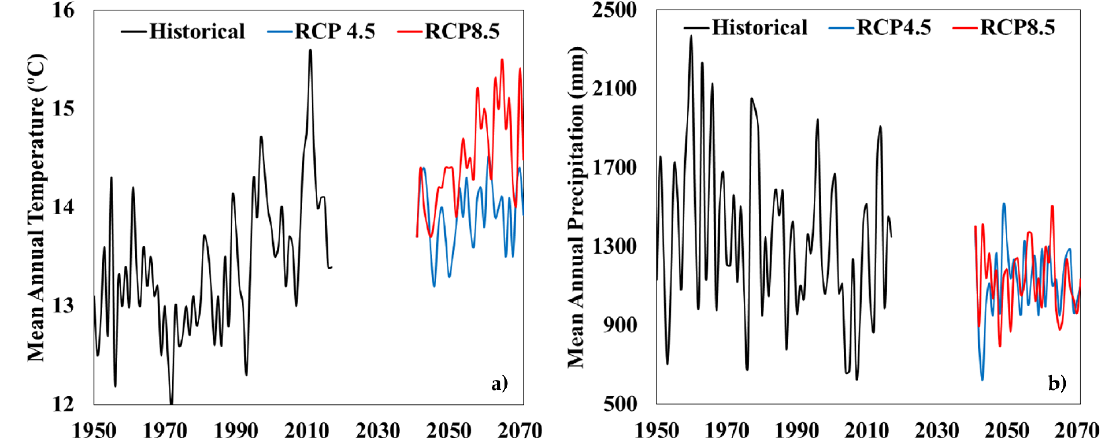
Figure 4. Temporal distribution of area-mean climate variables in the Paiva catchment: ( a ) mean annual temperature; and, ( b ) mean annual precipitation for the historical (1950–2015) and future scenarios (2041–2070) under RCP4.5 and RCP8.5.